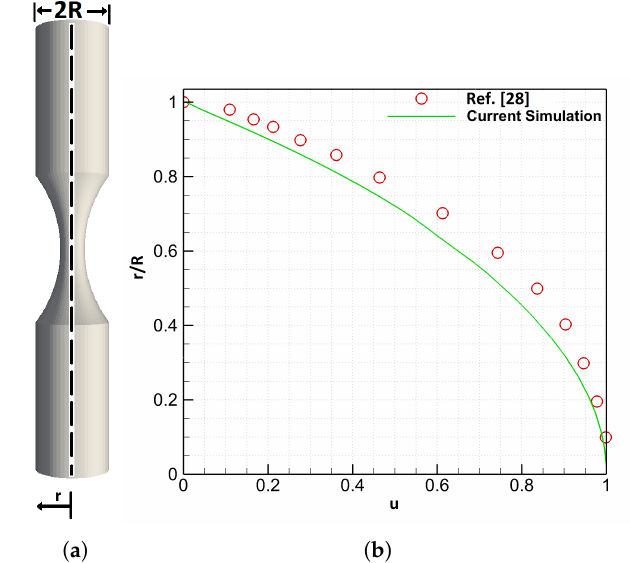
Figure 5. ( a ) Idealized stenosis geometry and ( b ) Comparison of the velocity profiles between the present study and Ref.